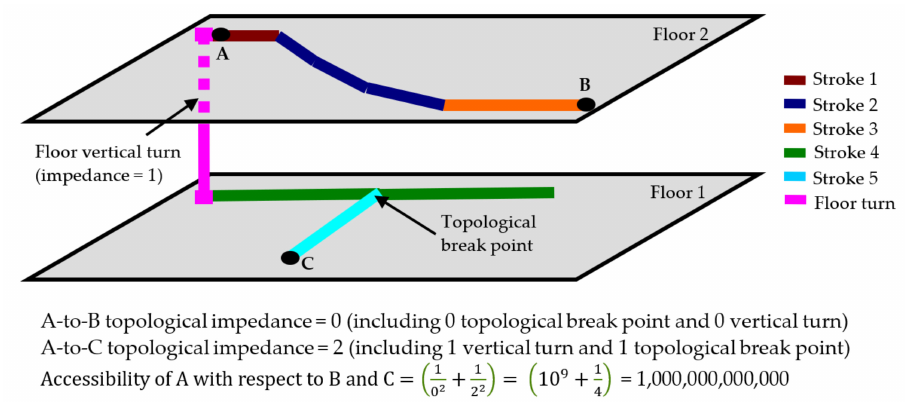
Figure 11. Topological impedance of traveling paths and accessibility estimation with α =